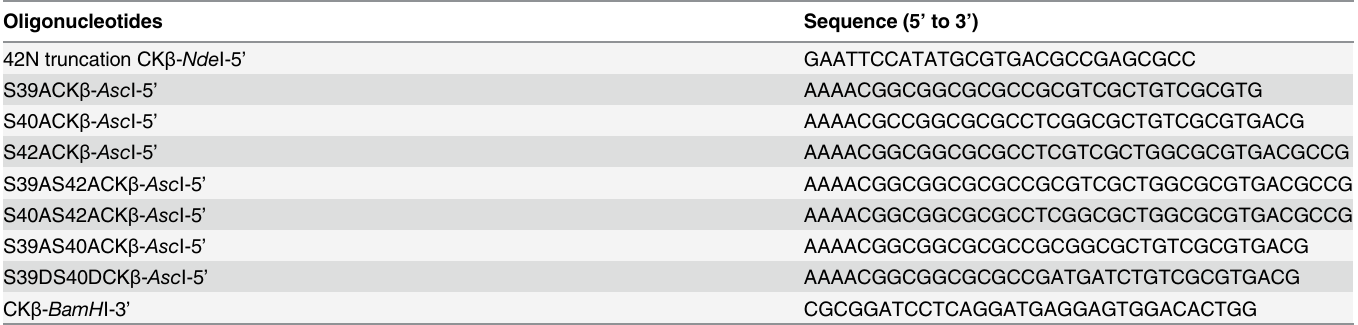
Table 4. Oligonucleotides used in this